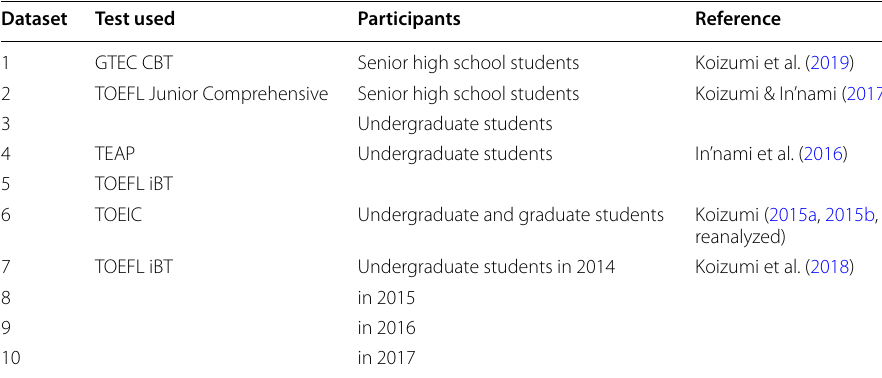
Table 1 Ten datasets in Study